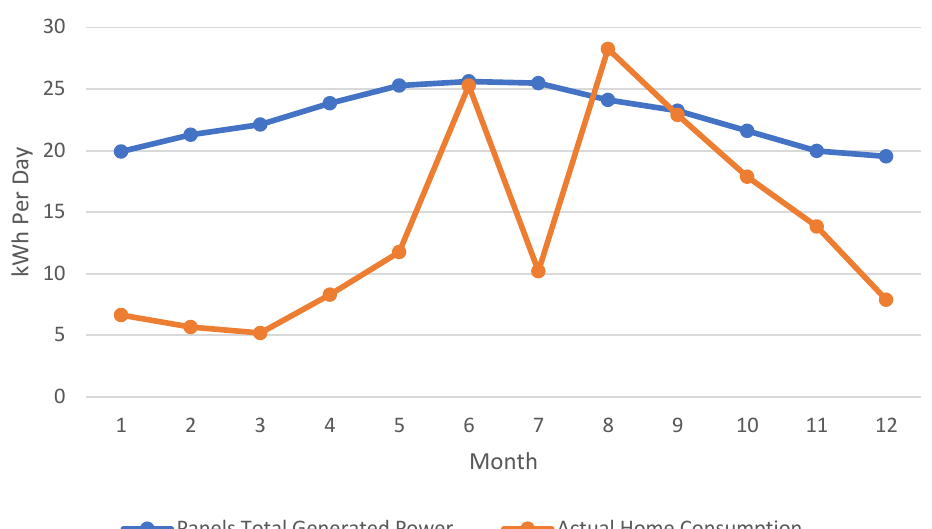
Figure 5. LPE vs. MPN (20% vs. 4 panels).